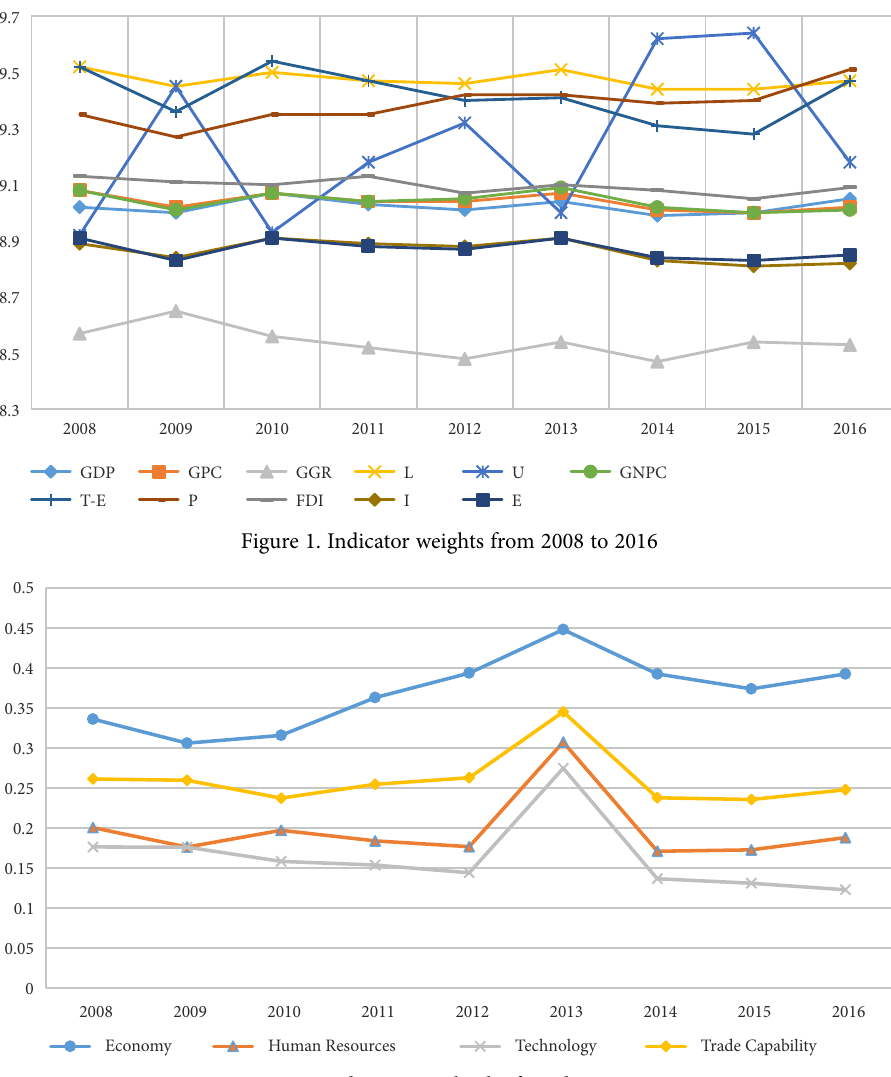
Figure 2. Indicator weights by four